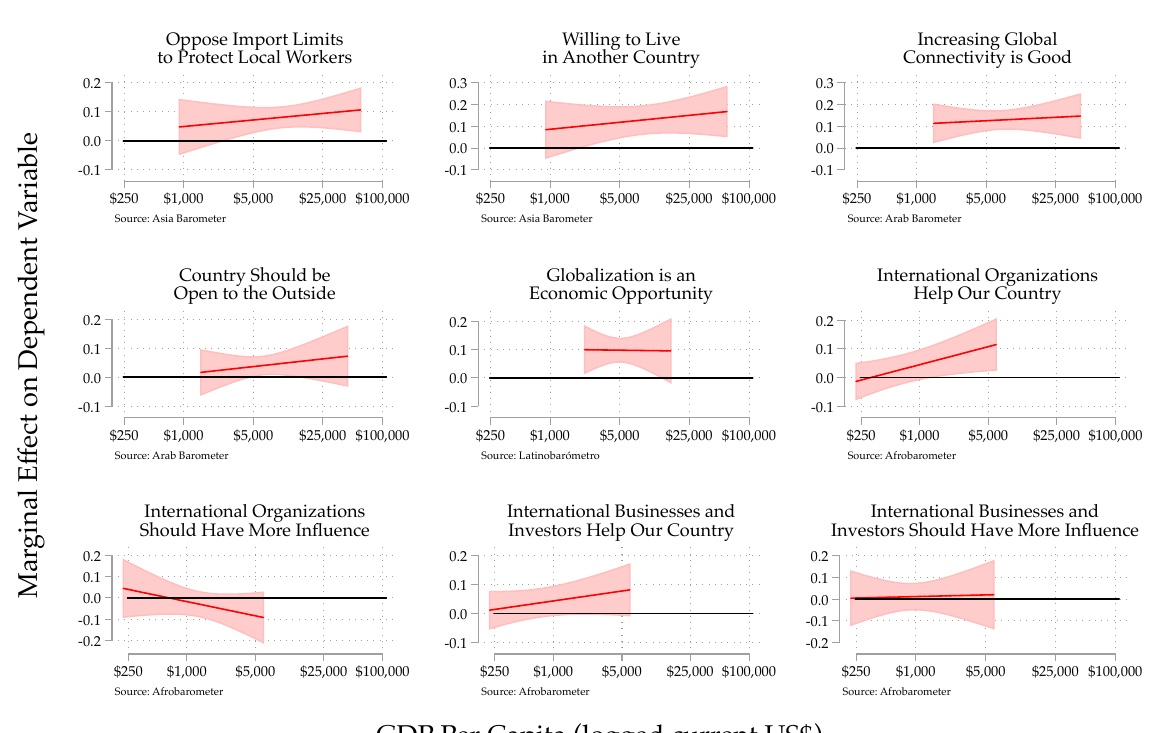
Figure 4: Marginal effect of urban elite status on cooperative-internationalist attitudes at levels of per capita GDP (Regional Surveys). Note: This figure illustrates the marginal effect of belonging to the urban profes- sional elite on each measure of cooperative-internationalist attitudes by levels of per capita GDP (logged scale) with shaded 95 percent confidence intervals. Results are drawn from hierarchical linear regression models in Table 2. The figure shows that gaps between elites and non-elites are more common and larger in higher-income